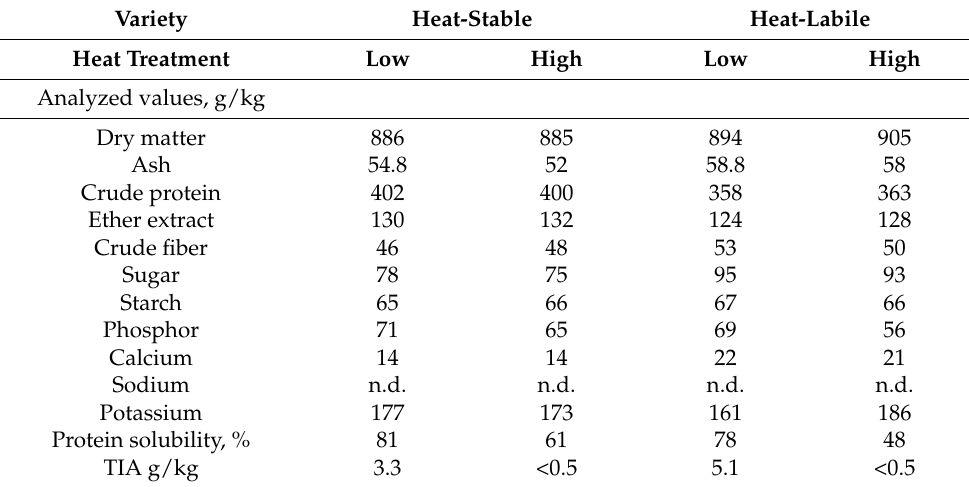
Table 2. Analytical data of soybean